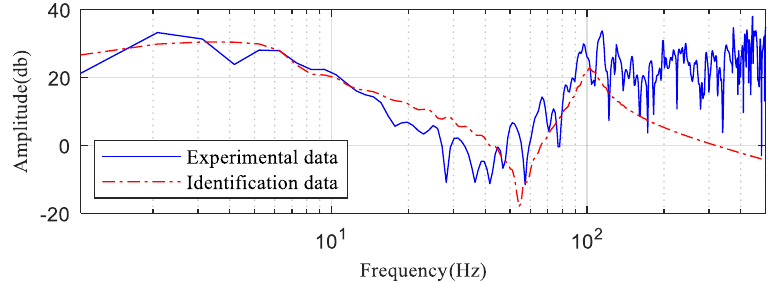
Figure 10. Amplitude of the FRF of experimental and identified data.